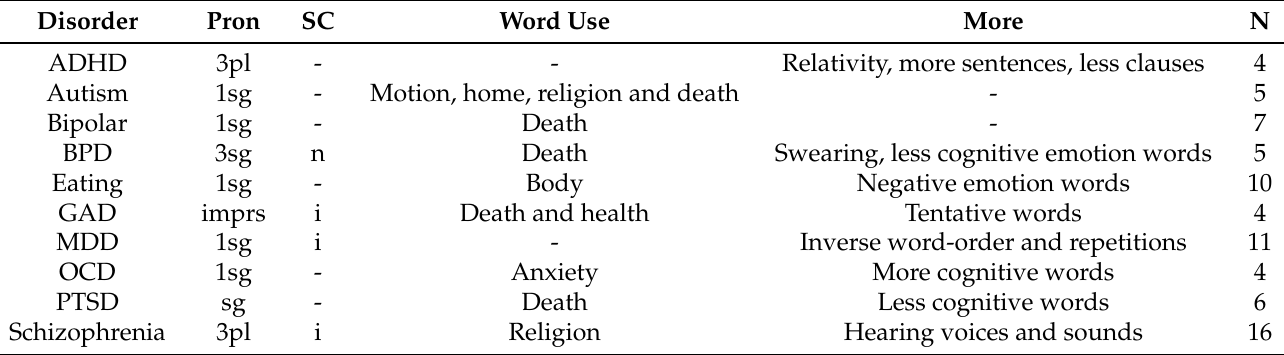
Table 1. Overview of associated language markers for ten mental health